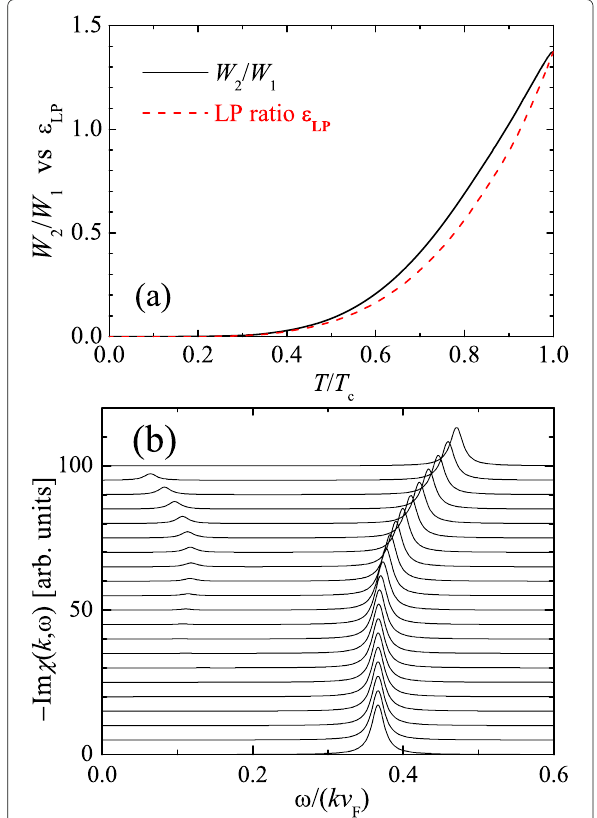
Fig. 6 a Comparison between the ratio of the second and first sound amplitudes in the dynamic structure factor ( W 2 / W 1 ) and the Landau– Placzek ratio (cid:8) LP in a unitary Fermi gas. b The imaginary part of the density response function at k = 0.1 k F and at different temperatures (each temperature is offset). The temperature is increased from zero to T c , in steps of 0.05 T c . For clarity, the delta functions in Eq. (21) are plotted as Lorentzians with a width 0.01 kv F . Adapted from Ref.